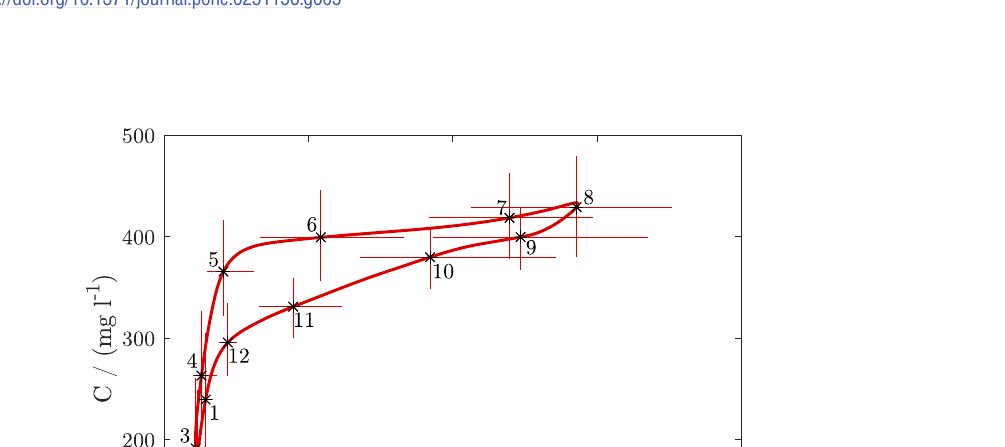
Fig 5. Wash load transport (black solid), concentration (red solid) and discharge (blue dash-dotted) of the Ayeyarwady River at Pyay between 2000 and 2015. Bold solid lines indicate average. Shaded area indicates intervals between 16% and 84% percentiles. Time series have been smoothed over a 30-day interval. 50% of the annual wash load is transported in less than three months during the wet season (vertical dashed line). All axes scaled proportionally to the annual mean (horizontal line).